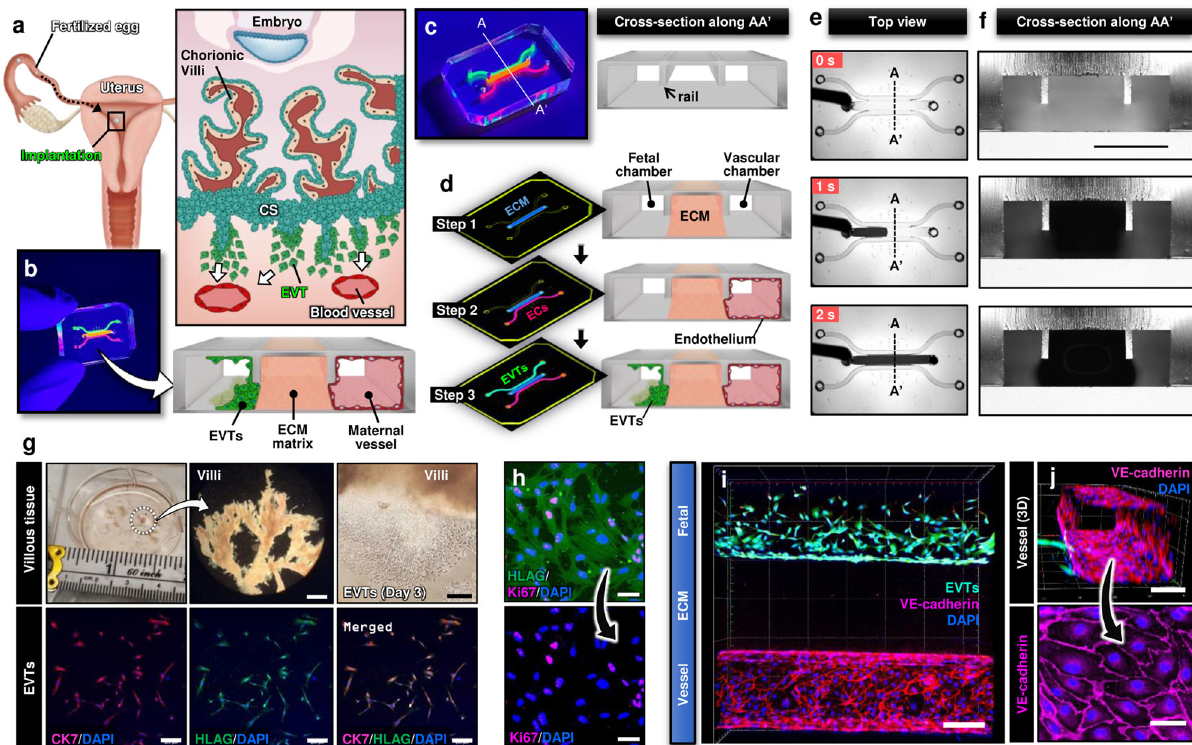
Fig. 1 Human implantation-on-a-chip. a Soon after implantation, EVTs begin to differentiate from precursor cells in the cytotrophoblast shell (CS) and invade into the uterus, a process that continues through the fi rst half of pregnancy. b Compartmentalized design of the implantation-on-a-chip device for in vitro modeling of EVTs and a maternal SA separated by maternal endometrium. c Architecture of the implantation-on-a-chip microdevice. The center and two side lanes have dimensions of 0.5 mm (width) × 0.3 mm (height) and 0.25 mm (width) × 0.3 mm (height), respectively. d Sequential steps of model construction. e Time-lapse imaging of ECM hydrogel precursor (colored black) injection into the center lane of the device. f Images of device cross- section to show capillary pinning-based physical con fi nement of injected hydrogel solution (dark solution) in the center lane. Scale bar, 500 μ m g (Top row) Photos of fi rst trimester termination tissue and EVT outgrowth from the tissue explants. Scale bars, 1 mm (middle) and 200 μ m (right). (Bottom row) The purity of the population was con fi rmed by immunostaining for cytokeratin 7, a trophoblast marker (magenta) and HLA-G, an EVT-speci fi c marker (green). The representative images of the villous tissue are from fi ve independent experiments. Scale bars, 200 μ m. h Immunostaining of HLA-G (green) and Ki67 (magenta) expression by EVTs cultured on coverslips in a 6 well plate, after 3 passages. The representative images of EVTs are from four independent experiments. Scale bars, 50 μ m. i Top-down confocal projection of the microengineered maternal-fetal interface at Day 1. EVTs in the fetal chamber were labeled with CellTracker Green (green). ECs were stained for VE-cadherin (magenta). The representative image is from three independent devices. Scale bar, 200 μ m. j Endothelial tube in the vascular compartment at Day 1. Magenta and blue show VE-cadherin and nuclear staining, respectively. The representative images are from three independent devices. Scale bars, 100 μ m (top) and 50 μ m (bottom). EVTs: Extravillous trophoblasts, CS: Cytotrophoblastic shell, ECs: Endothelial cells, ECM : Extracellular matrix, CK7 : Cytokerain 7, HLA-G : human leukocyte antigen